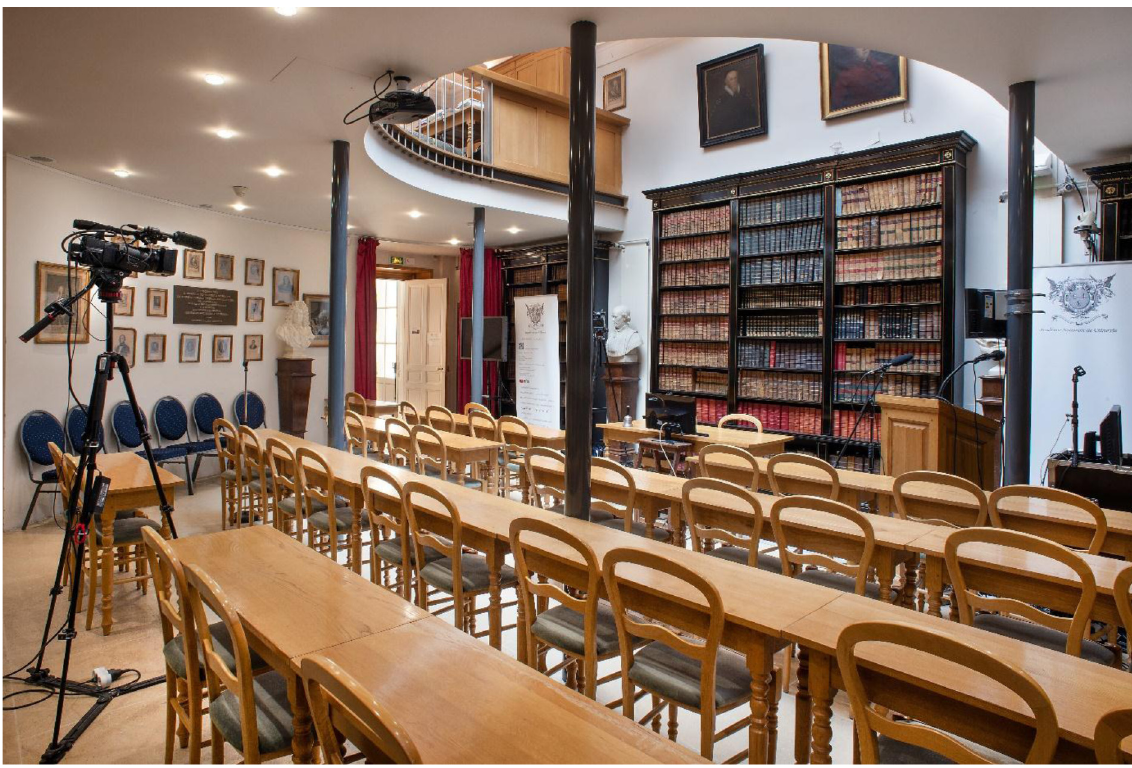
Fig. 4. Meeting room, at the current seat of the Academy.